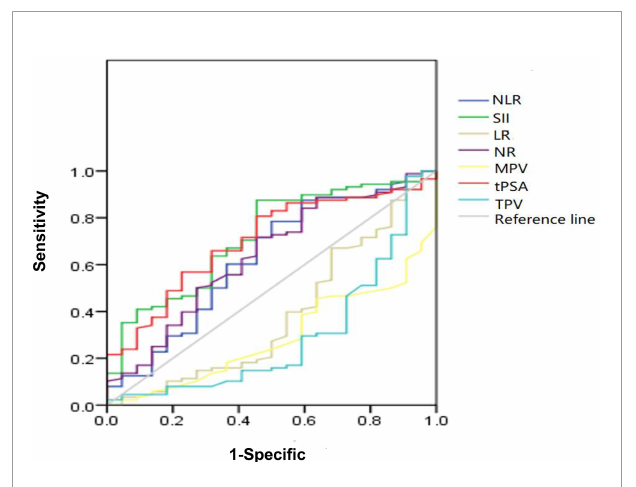
FIGURE 2 | Diagnostic role of SII, NLR, NR, tPSA, TPV, MPV, and LR in detecting localized PCa by ROC curve analysis. Among in fl ammatory markers, SII had largest AUC of 0.719, the second was NLR with AUC of 0.697, the third was NR with AUC of 0.647; the AUC of tPSA was 0.708; both SII and NLR got the comparable AUC with tPSA.